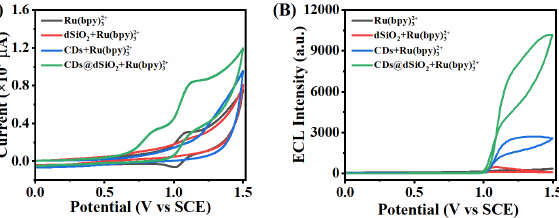
Figure 3. ( A ) CV curves and ( B ) ECL behaviors of Ru(bpy) 32+ (black curve), dSiO 2 -Ru(bpy) 32+ (red curve), CDs-Ru(bpy) 32+ (blue curve), and CDs@dSiO 2 -Ru(bpy) 32+ (green curve) in a solution of 0.1 M PBS (pH = 7.4) containing 50 μM Ru(bpy) 32+ . The voltage of PMT was set at 600 V.